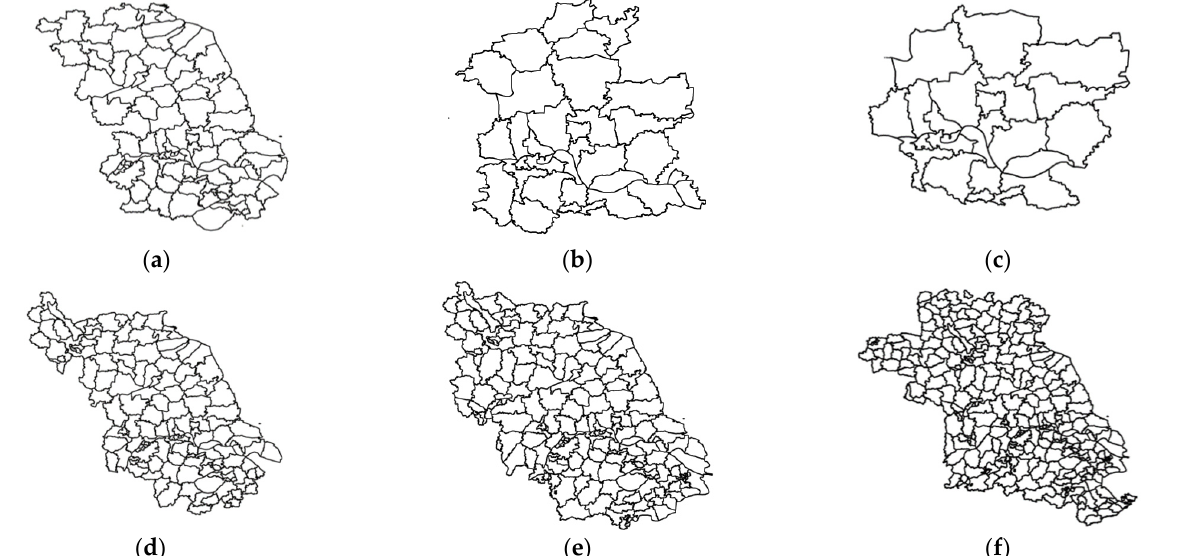
Figure 9. Adding and cutting effect of county-level administrative boundaries of Jiangsu province. (a) Cut 10%. (b) Cut 70%. (c) Cut 80%. (d) add 10%. (e) Add 50%. (f) Add 100%. Table 3. Watermark extraction results under cropping and adding attacks.